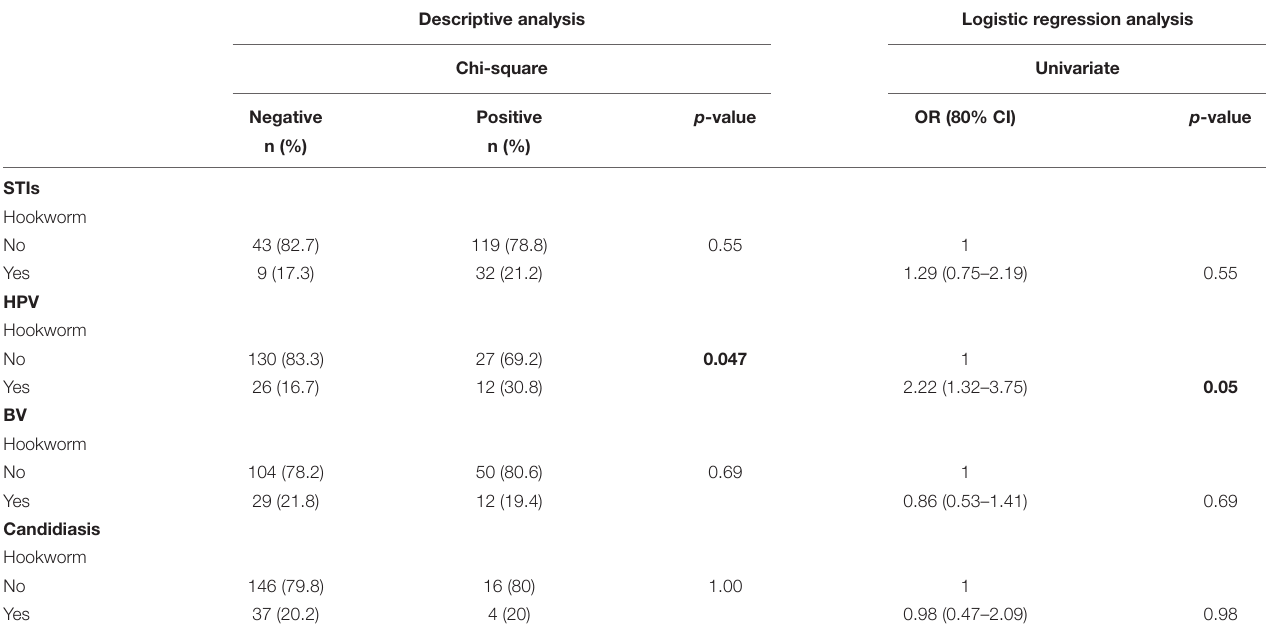
TABLE 1 | Descriptive and logistic regression analysis of hookworm infection associated with